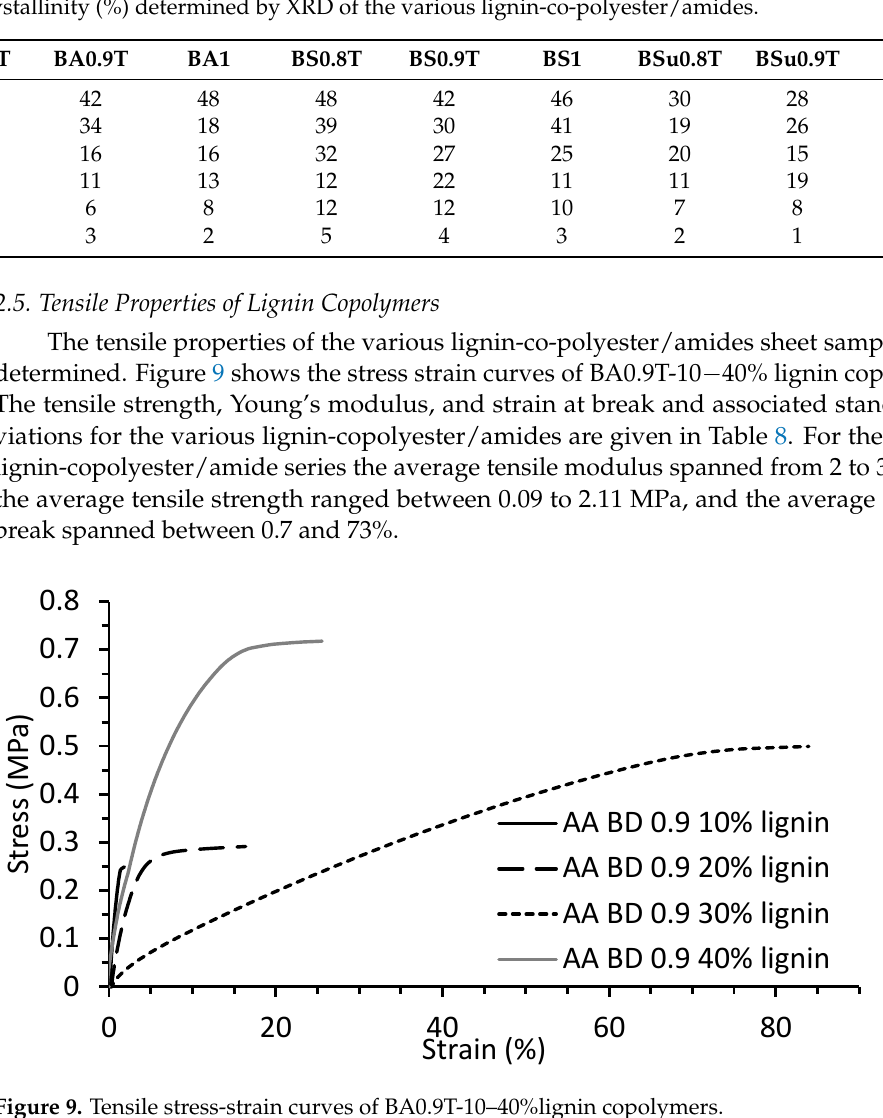
Figure 9. Tensile stress-strain curves of BA0.9T-10–40%lignin copolymers. Table 8. Tensile properties (strength, modulus, and strain at break) of the various lignin-co-poly- ester/amides formulations were determined from tensile stress strain curves.